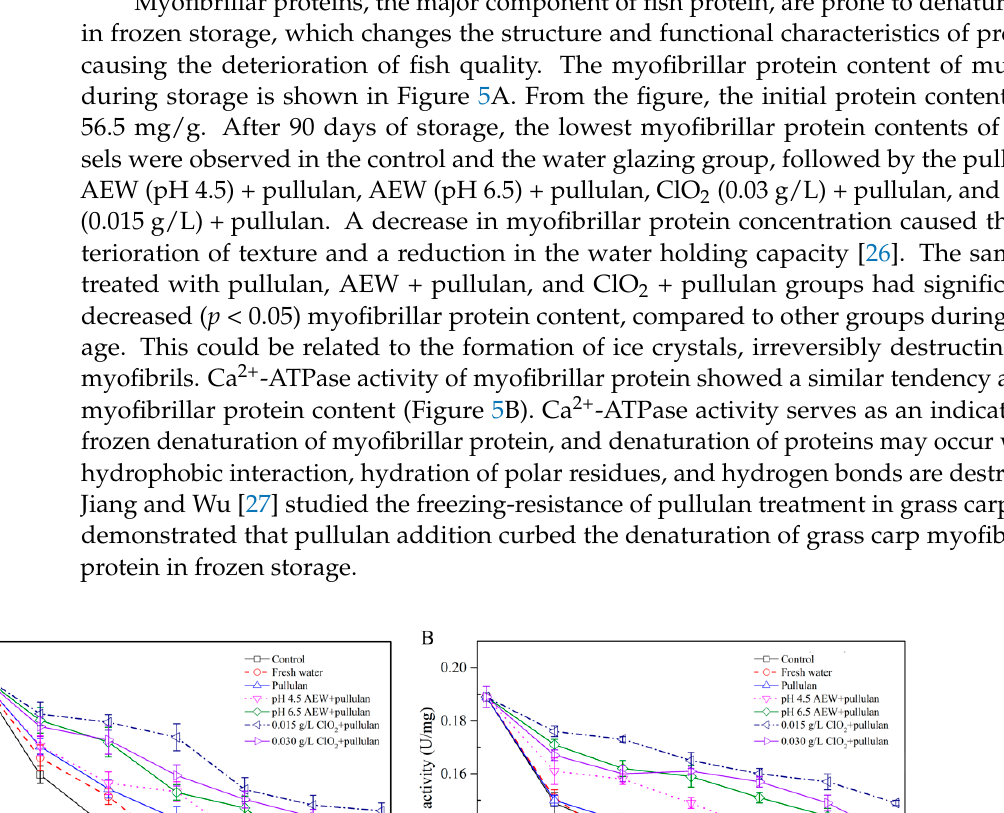
Figure 4. pH value ( A ) and TVBN content ( B ) of half-shell mussels treated with the control, water, and combined glazing solutions during 90 days of frozen storage.